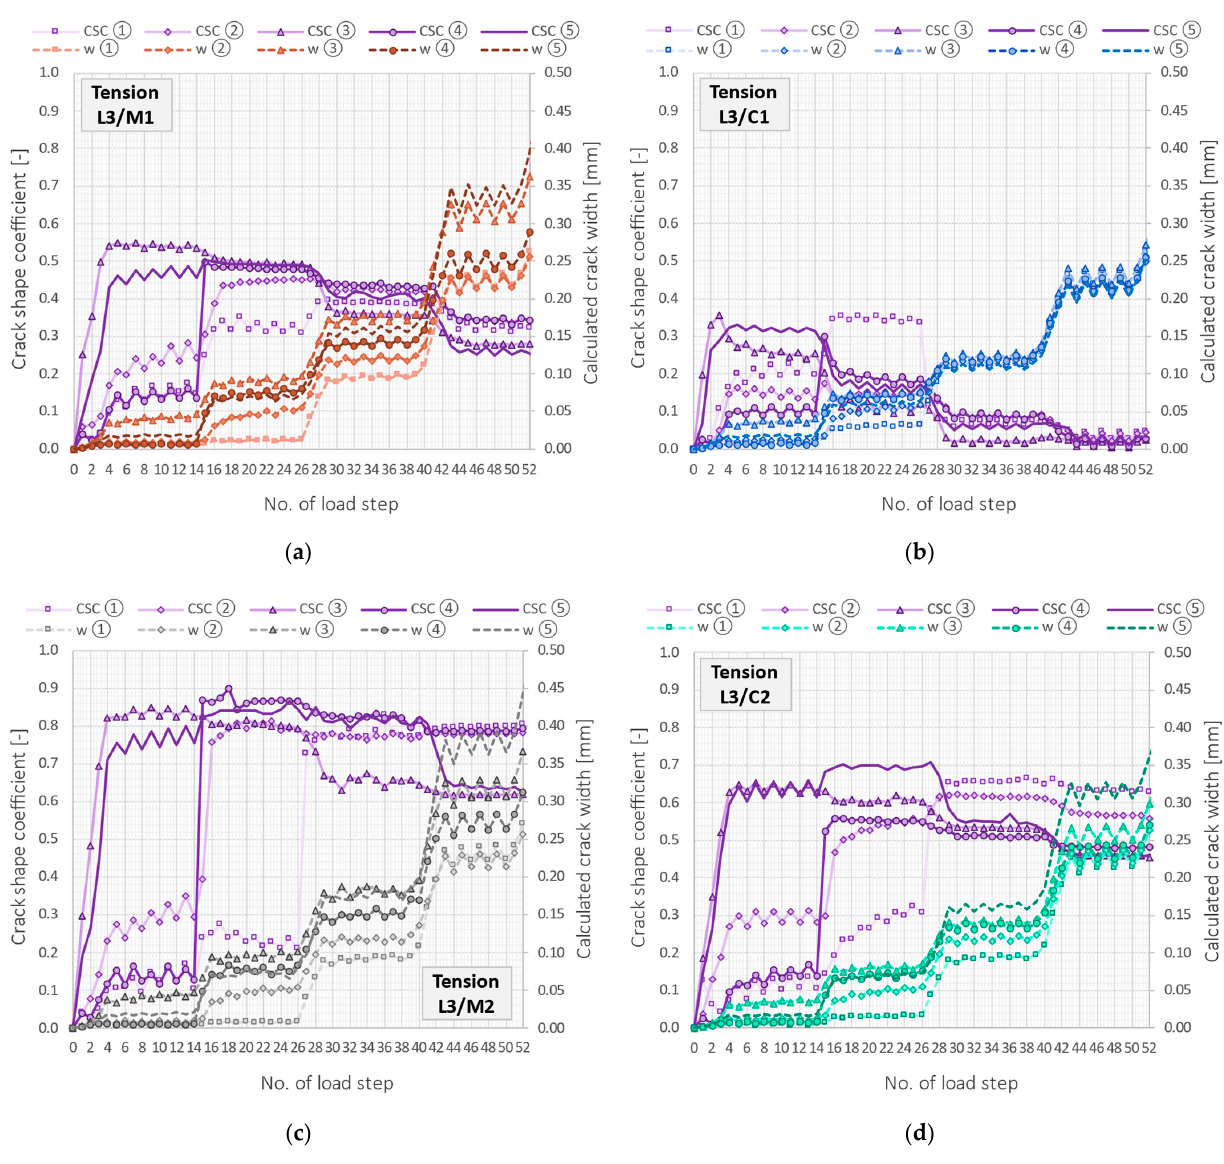
Figure 28. Beam L3/tension zone: crack shape coefficients (purple lines) and widths of five selected cracks calculated based on the following DFOS tools: ( a ) M1; ( b ) C1; ( c ) M2; ( d ) C2.